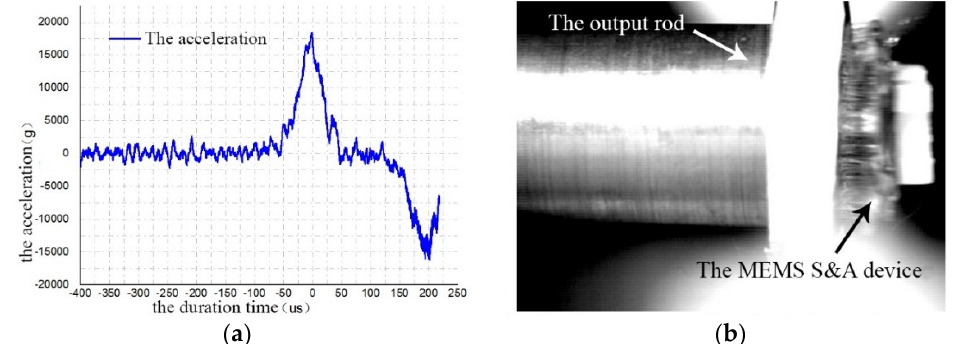
Figure 20. The anti‑load test result of the S&A device. ( a ) The setback acceleration; ( b ) the Figure captured by the high speed camera.